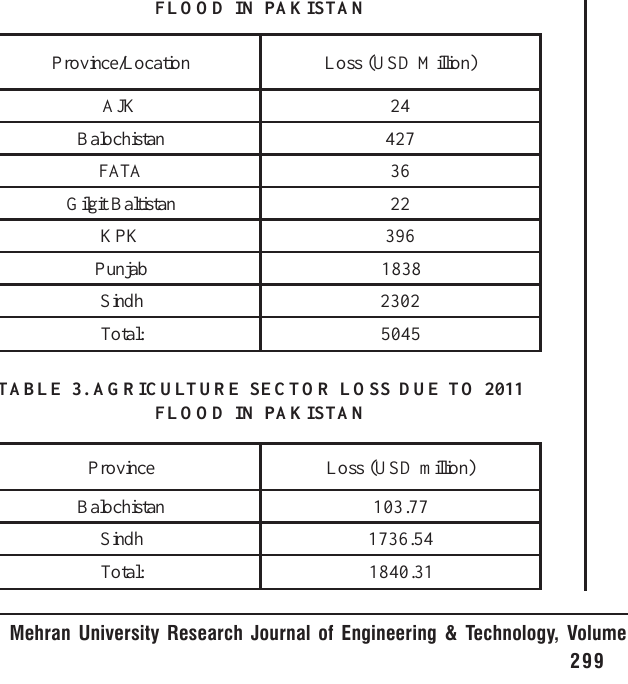
TABLE 2. AGRICULTURE SECTOR LOSS DUE TO 2010 FLOOD IN PAKISTAN